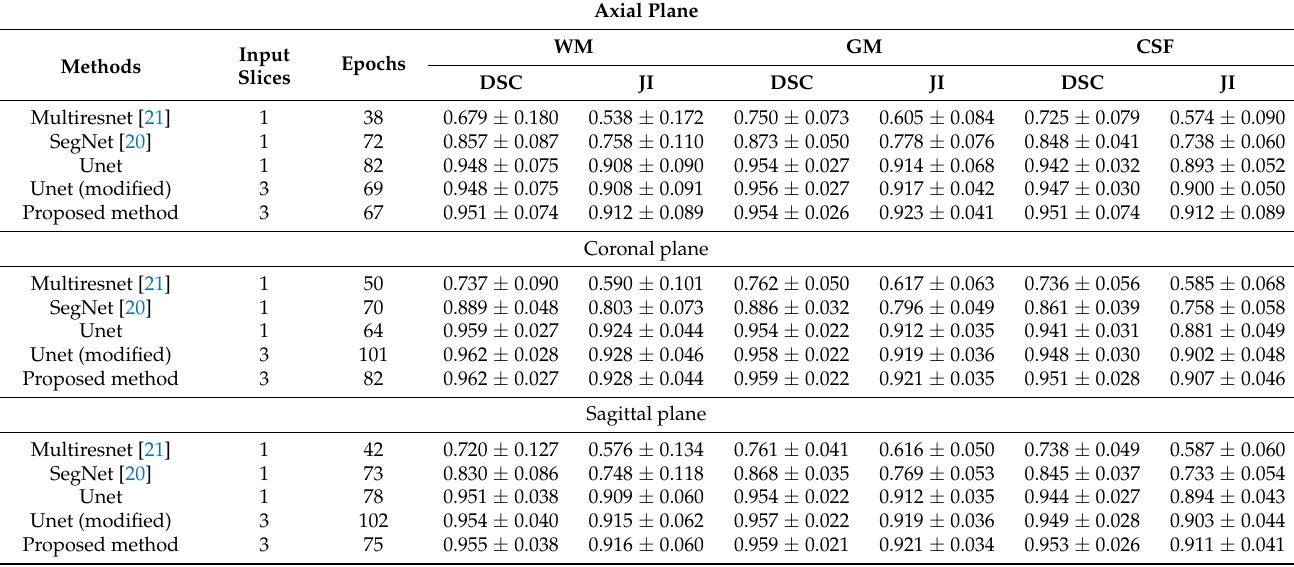
Table 3. Segmentation result comparison between the Multiresnet, SegNet, single-slice input UNet, multi-slice UNet, and the proposed